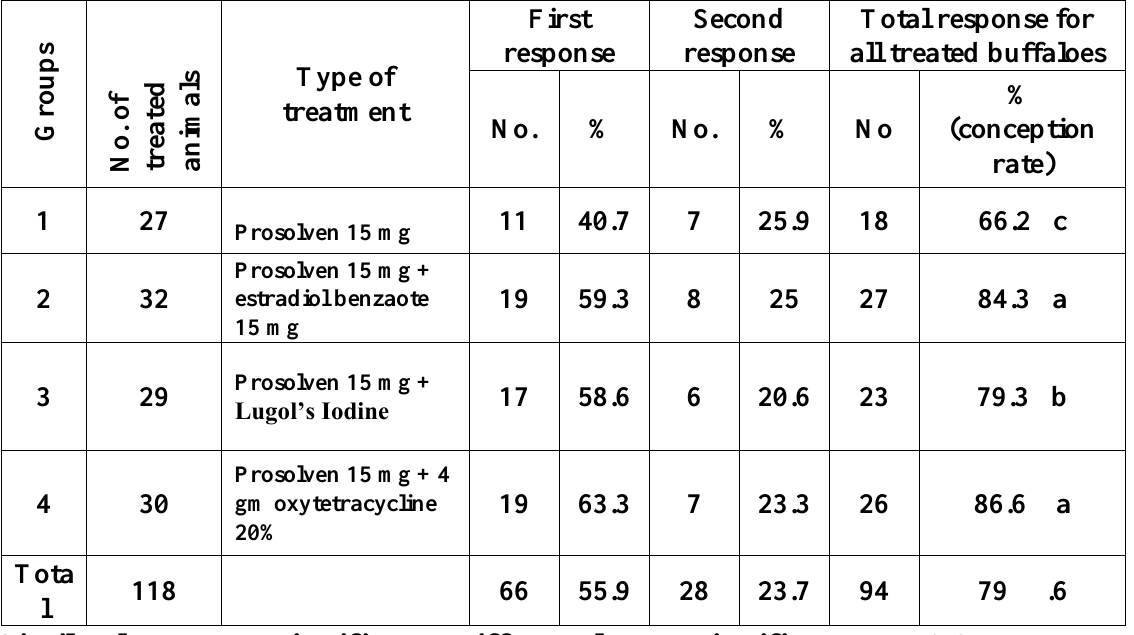
Table 1: Reveals the type of treatment and degree of response in postpartum pyometra in buffaloes .